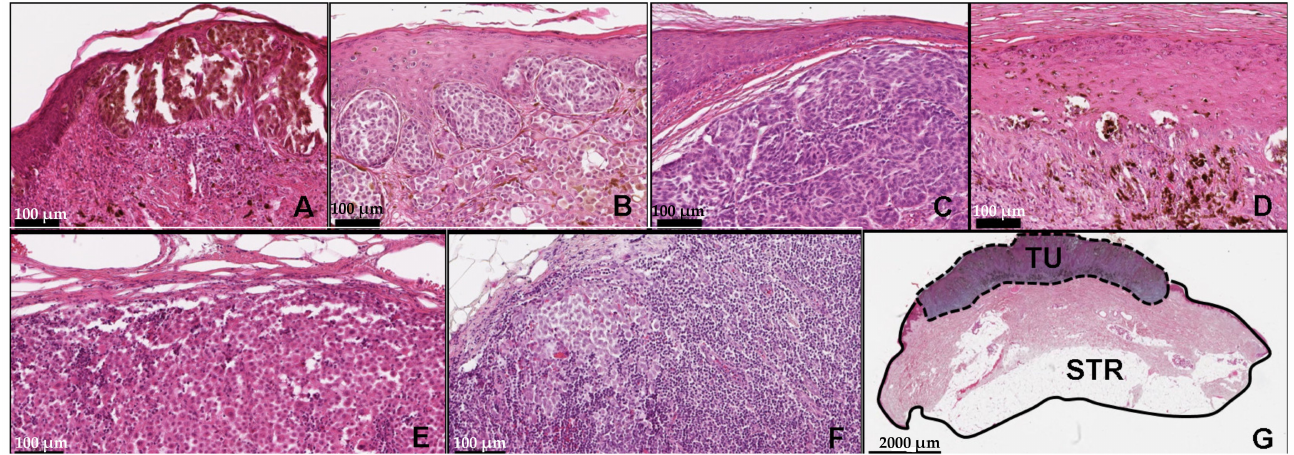
Figure 2. Histopathologic features of the representative cases in the study. Image captures, representing the spectrum of melanoma sample subtypes, including SSM (superficial spreading melanoma) ( A ), SSM with a vertical involvement (superficial spreading melanoma with vertical involvement) ( B ), NM (nodular melanoma) ( C ), ALM (acrolentiginous melanoma) ( D ), as well as both cutaneous ( E ) and lymphatic ( F ) metastases. Each sample also underwent a tumor (TU)/stroma (STR) ratio assessment ( G ) (HE (hematoxylin-eosin); OM (optimal magnitude) 112 ×